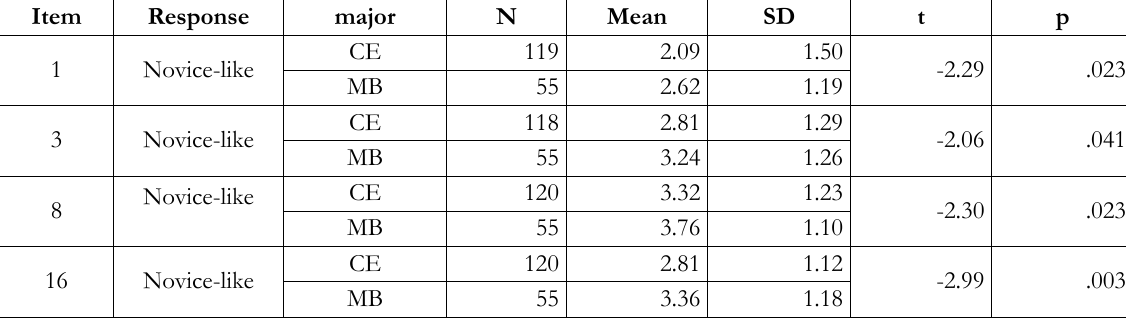
Table 2. Descriptive statistics for items that significant differences are observed between different